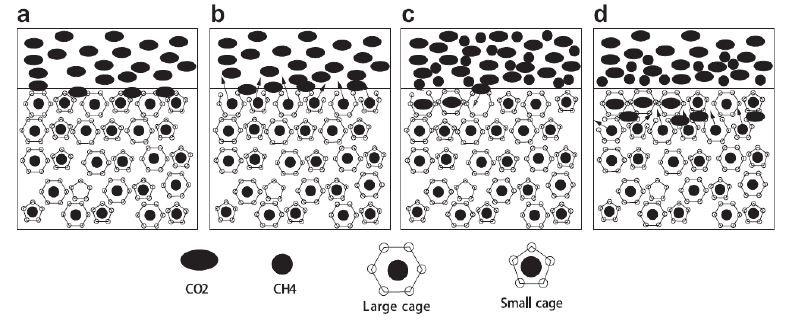
Figure 18. Schematic diagram for CH 4 – CO 2 replacement in hydrates [270].